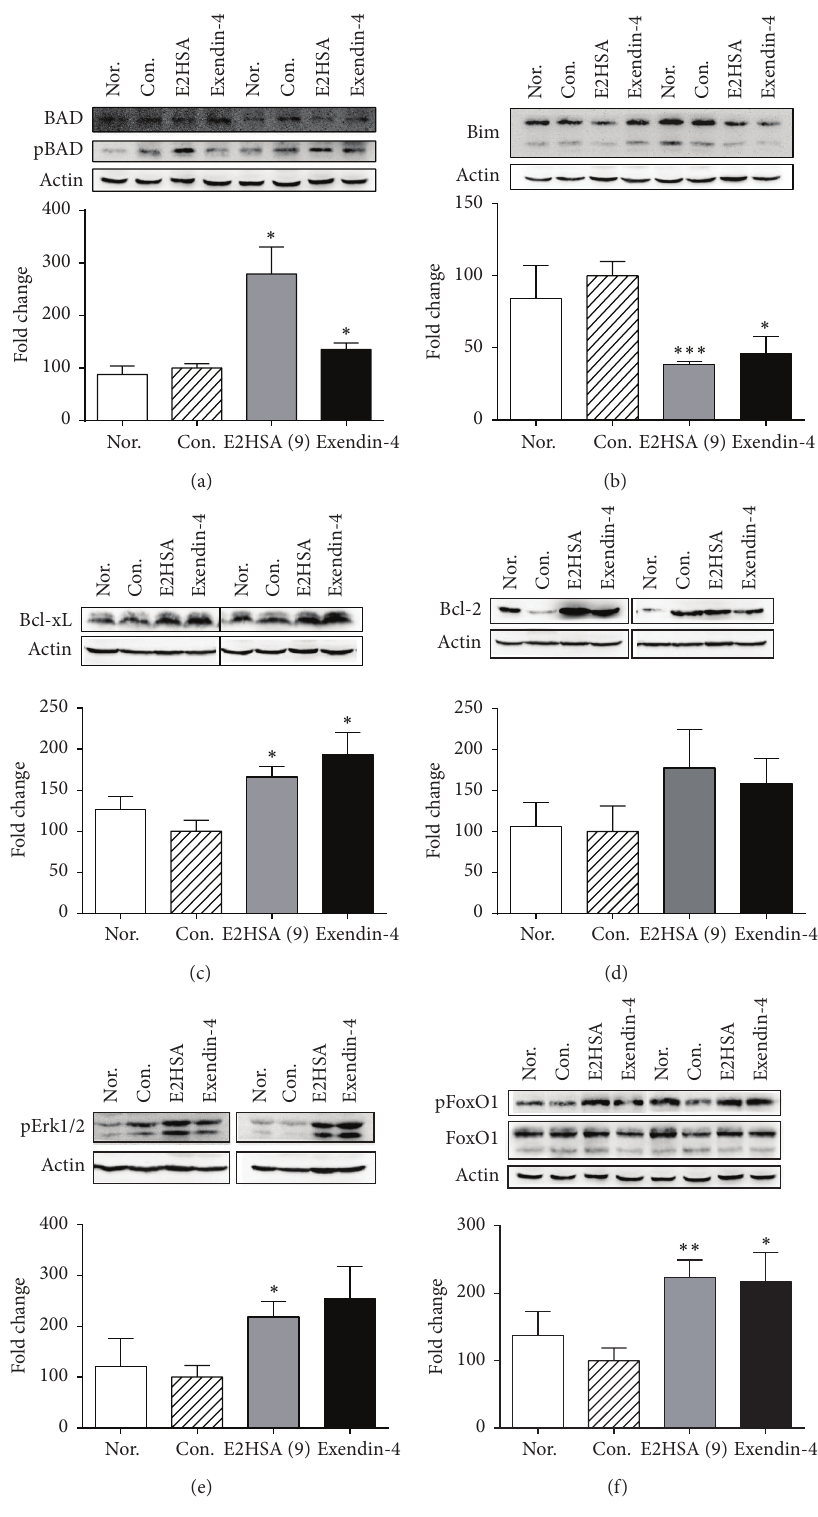
Figure 9: Chronic treatment with E2HSA regulated the expression of Bcl-2 family proteins and FoxO1. Data are from pancreas tail samples. ((a)–(f)) The upper panels show 2 representative Western blots from each group. Protein bands were determined by densitometry analysis and expressed as fold change, after correction for 𝛽 -actin expression levels, relative to Con. mice. ((a), (f)) The ratio of phosphorylated protein to total protein of each group was first determined; then the fold change was calculated by comparing to Con. mice. Nor., db/m mice treated with normal saline. Con., db/db mice treated with normal saline. E2HSA (9), db/db mice treated with 9 mg/kg E2HSA. Data are expressed as mean ± S.E.M ( 𝑛 = 4 - 5 ). ∗ 𝑃 < 0.05 , ∗∗ 𝑃 < 0.01 , and ∗∗∗ 𝑃 < 0.001 versus